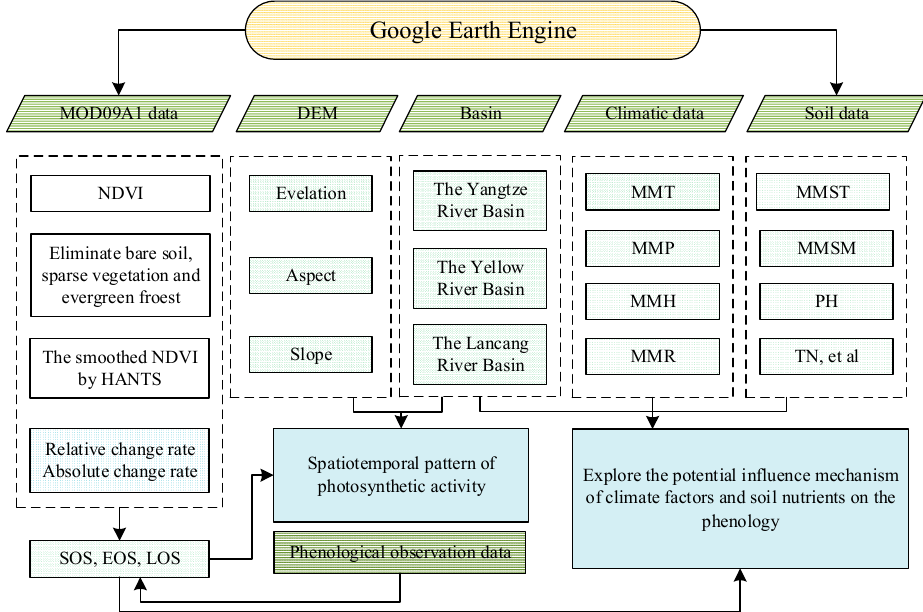
Figure 1. Flow chart of research ideas for this paper. NDVI, HANTS, SOS, EOS, LOS, DEM, MMT, MMP, MMH, MMR, MMST, MMSM, pH, and TN indicate the normalized difference vegetation index, harmonic analysis of time series, start of the growing season, end of the growing season, length of the growing season, digital elevation model, monthly mean temperature, monthly mean precipitation, monthly mean relative humidity, monthly mean shortwave radiation, monthly mean soil temperature, monthly mean soil moisture, pH (H 2 O), and total N, respectively.